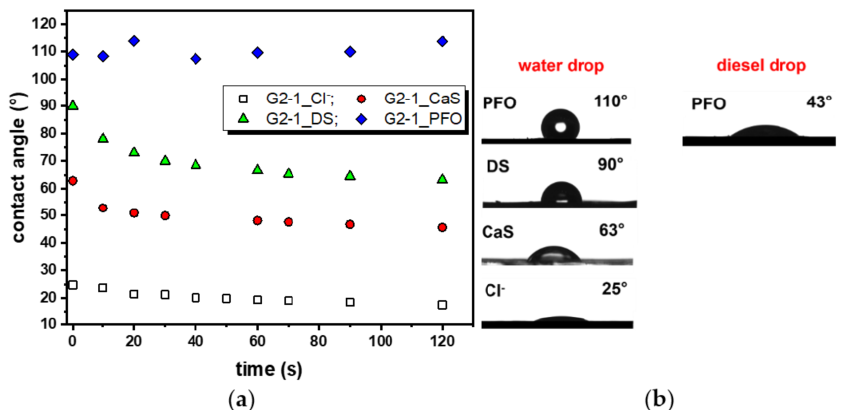
Figure 4. ( a ) Contact angles and time evolution of the contact angle on the surface of the G2-1 hydrogel type, before Cl (white square) and after the exchange with CaS (red bullet), DS (green triangle), and PFO (blue diamond) anions; ( b ) Photographs of 3 µ L of water (left) or diesel (right) droplets, present on the surface at the beginning of the measurements.